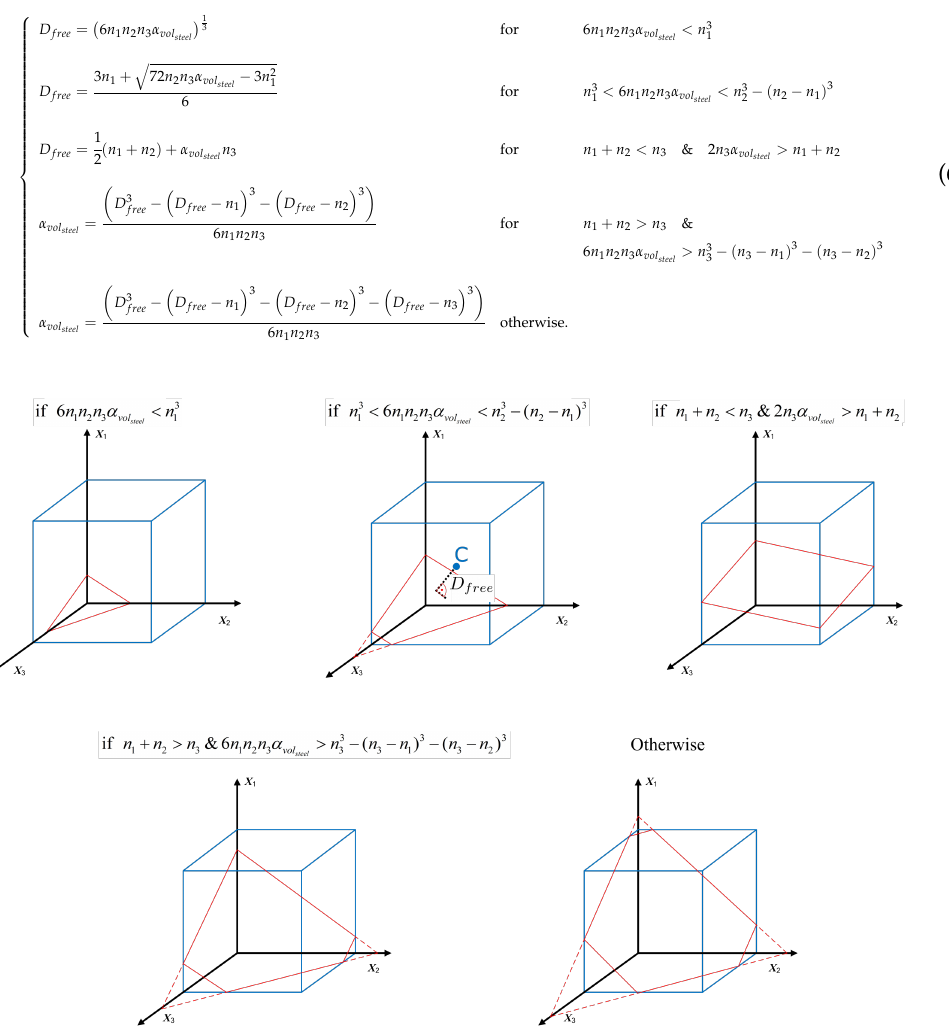
Figure 3. Calculated distance between the cell center and the free surface within the cell, D free , depending on the approximated plane of the free